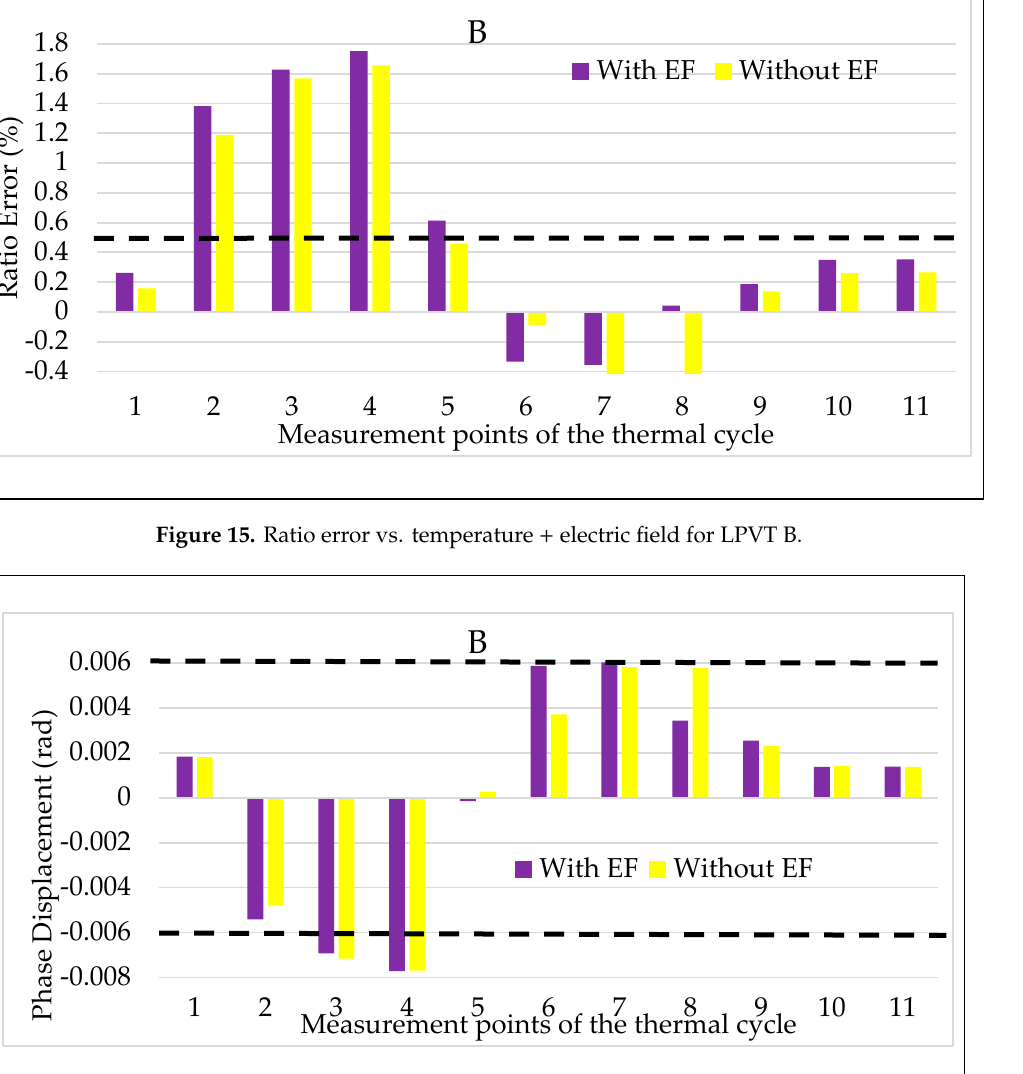
Figure 16. Phase displacement vs temperature + electric field for LPVT B.